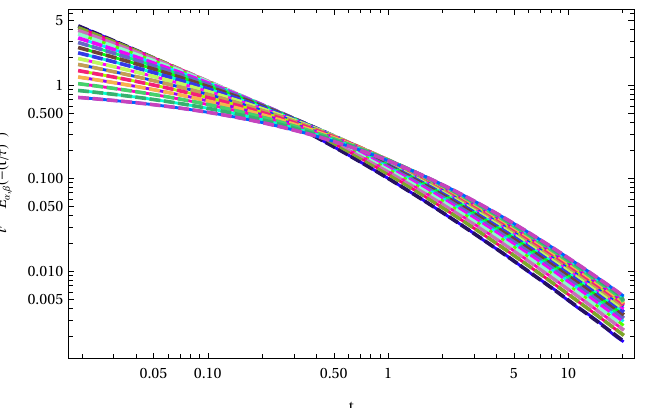
Figure 17. A variety of solutions of the HN model with β = αγ for different values of γ . From top to bottom on the right end of the graph, the γ values varied and α kept fixed. The solid line represents the SG inverse Laplace result, while the dashed line is the series implementation of t β − 1 E γ using 126 terms. The SG inverse Laplace results are not limited to the shown scale. The limitation results here by using the series representation. Parameters are χ 0 = 1, τ = 1, α = 1/2, and γ is taken from [3/5,2] in steps of 1/10. The number of Sinc points is N = 128.